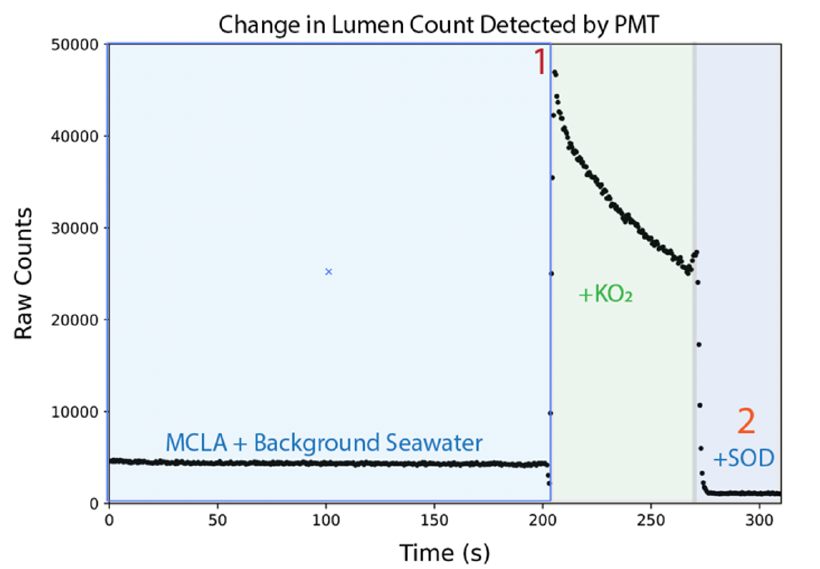
Figure 4. KO 2 calibrations were done to test the predicted O – 2 concentration generated by the thermal degradation of SOTS-1. A KO 2 calibration begins with the collection of a background signal. With the difference in absorbance at 240 nm of a KO 2 solution before (1) and after the addition of SOD (2), and the observed slope of the O – 2 decay, a calibration factor (raw photon count/ nM O – 2 ) can be